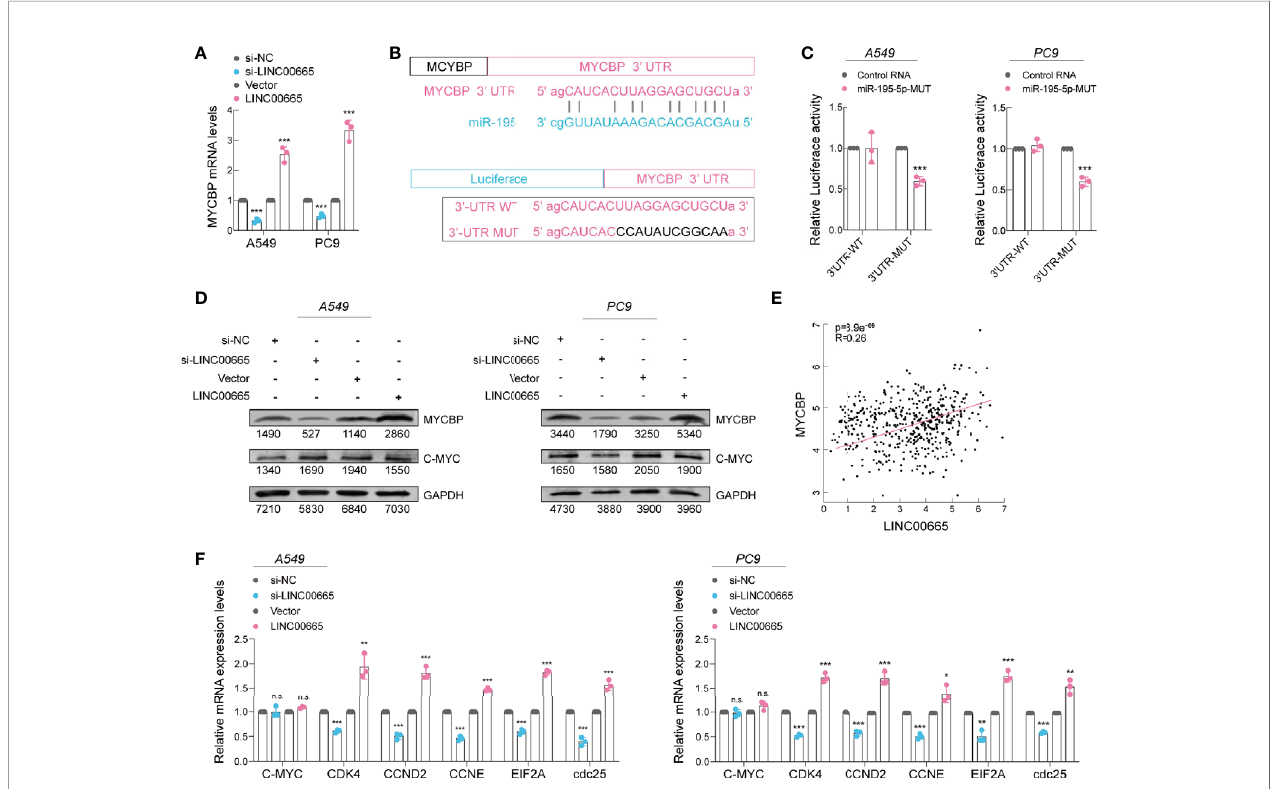
FIGURE 5 | miR-195-5p promotes progression of LUAD via targeting MYCBP. (A) MYCBP mRNA expression level in 549 and PC9 cells after knockdown or overexpression of LINC00665 determined using qRT-PCR. (B) Upper panel: miR-195-5p can bind to the 3 ’ -UTR of MYCBP mRNA; Lower panel: Schematic graph illustrating the mutation of potential binding sites between miR-195-5p and the 3 ′ -UTR regions of MYCBP. (C) MYCBP 3 ’ -UTR and miR-195-5p binding site analyzed with dual-luciferase reporter assay. (D) MYCBP and C-Myc protein expression levels detected using western blot analysis in A549 and PC9 cells with knockdown or overexpression of LINC00665. (E) Expression of LINC00665 and MYCBP that are positively correlated (Data from TCGA). (F) C-Myc downstream mRNA levels measured using qRT-PCR in A549 and PC9 cells after LINC00665 knockdown or overexpression. *p < 0.05; **p < 0.01; ***p < 0.001. n.s., no signi fi